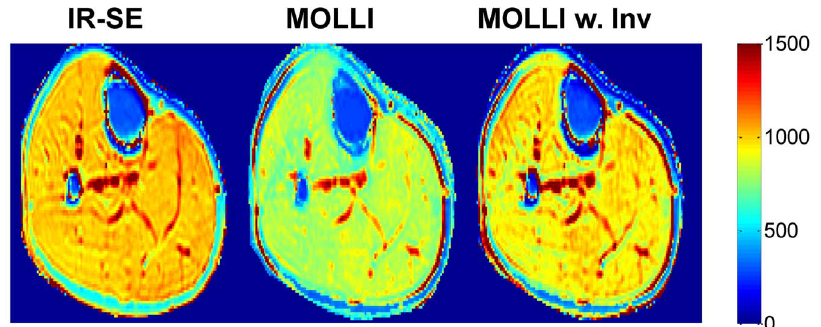
Figure 3. Example of T 1 maps (in ms) obtained with IR-SE, conventional MOLLI fitting and MOLLI fitting with inversion correction in the calf muscle at 30 6 flip angle.